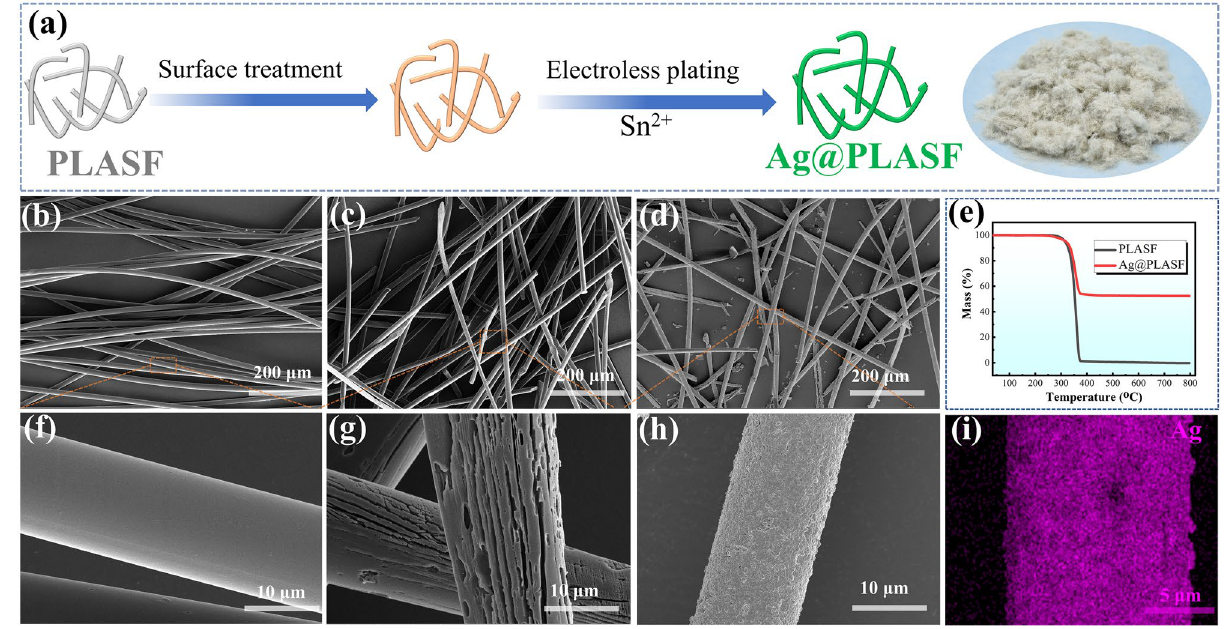
Fig. 1 a Schematic illustration of the fabrication process for AAF and the digital photograph of AAF; SEM images of b, f PLASF, c, g treated PLASF, d, h AAF; e TGA curves of PLASF and AAF; i Ag elemental mapping image of